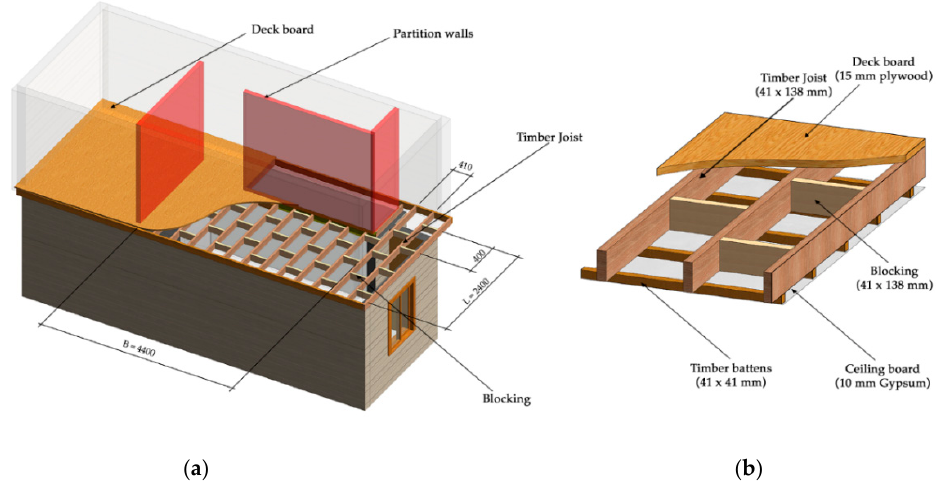
Figure 5. ( a ) Layout and dimensions of the Field-2.4-W timber floor.; ( b ) ceiling-to-joist connections of the Field-2.4-W timber floor.